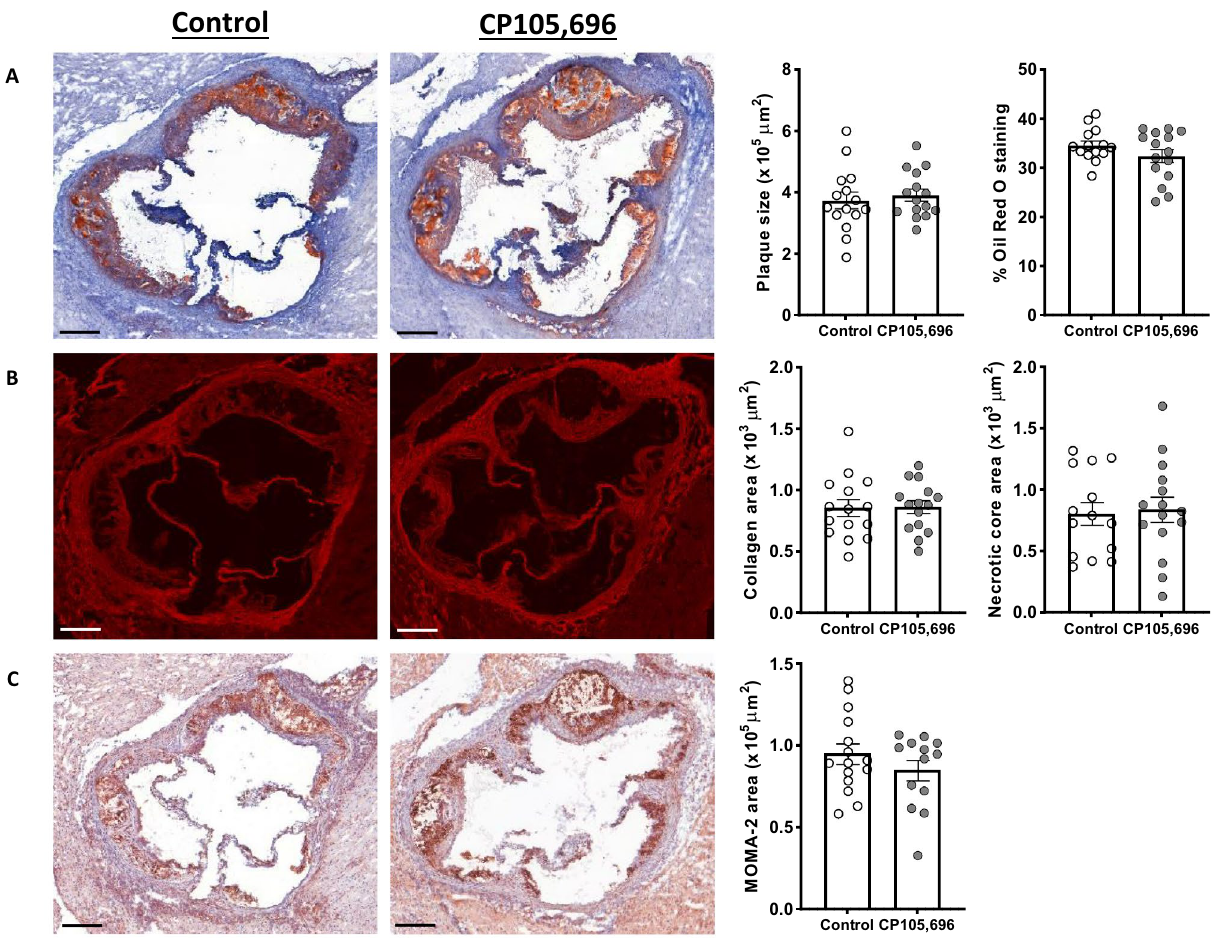
Figure 4. Inhibition of the BLT1-LTB 4 axis did not alter plaque morphology in advanced atherosclerosis. ( A ) Atherosclerotic plaque size and percentage Oil Red O staining in the plaque did not differ upon treatment with CP105,696 as assessed by Oil-Red O staining of the aortic root. ( B ) Sirius red staining of the aortic root did not reveal differences in plaque collagen and necrotic core area in CP105,696 treated mice versus controls. ( C ) BLT1-antagonism did not affect the MOMA-2 macrophage area in the aortic root. All representative pictures are taken at optical magnification 5x; the bar indicates 200 μm. n = 13–15 per group. Data represent mean ± SEM.